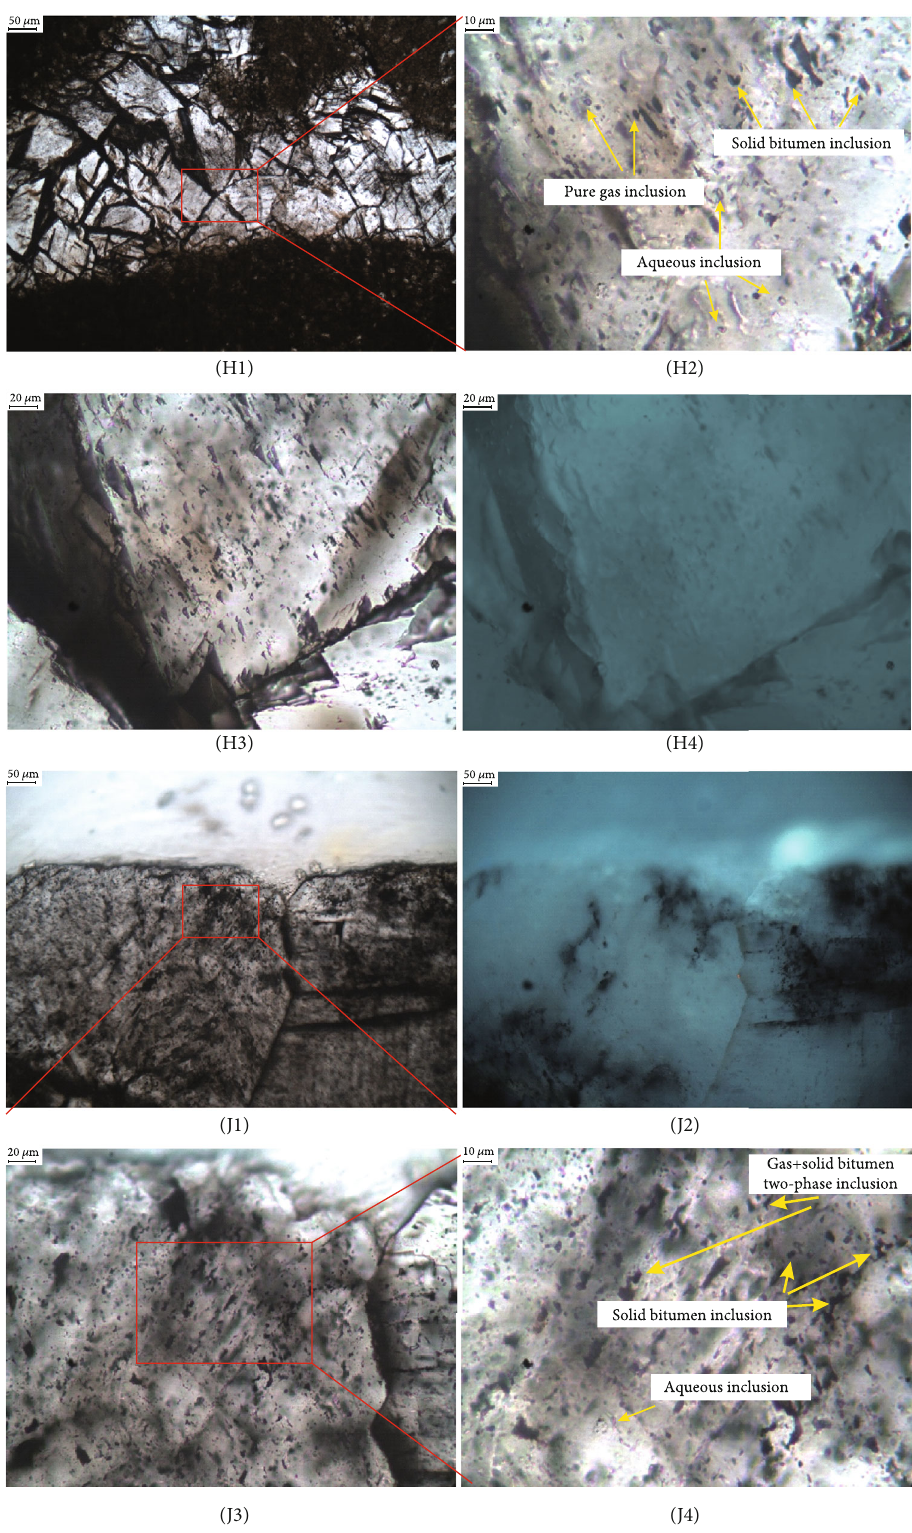
Figure 6: The Longwangmiao Formation Well MX20. Photos of fl uid inclusion petrologic and petrographic observation of (H1 – H3) (-) 4597.29-4598.73m, synchronous capture of gas-phase inclusions, bitumen inclusions, and brine inclusions in dolomite under di ff erent polarized light multiples. (H4) (UV) Non-gas-phase and bitumen inclusions. (J1), (J3), and (J4) (-) 4618.64-4618.86m, synchronous capture of gas phase+bitumen inclusions, bitumen inclusions and aqueous inclusions in dolomite displayed at di ff erent polarized light multiples. (J2) (UV) Non fl uorescing hydrocarbon